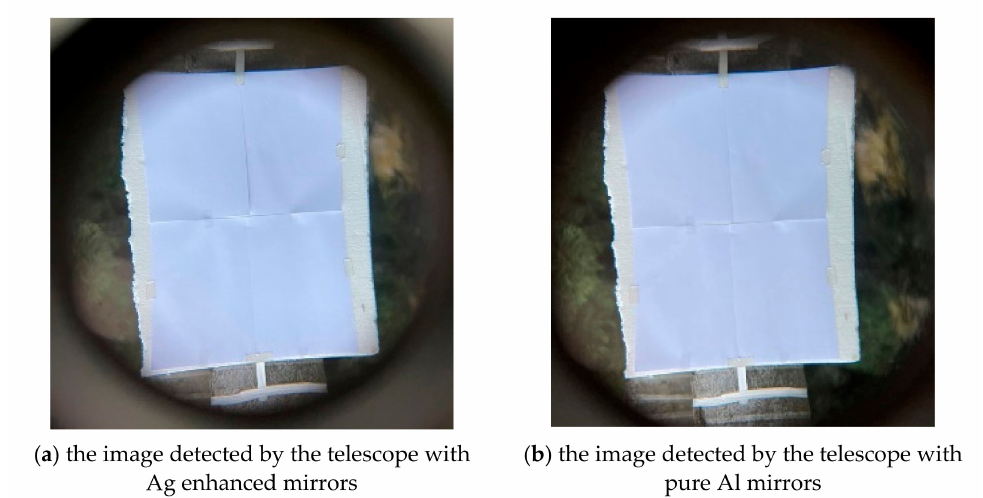
Figure 10. A prominent white object, combined with four sheets of A4 white paper, was hung next to a coconut tree and placed about 40 m away. Photo ( a ) taken with the Ag-enhanced system, and photo ( b ) taken with the pure Al-coated